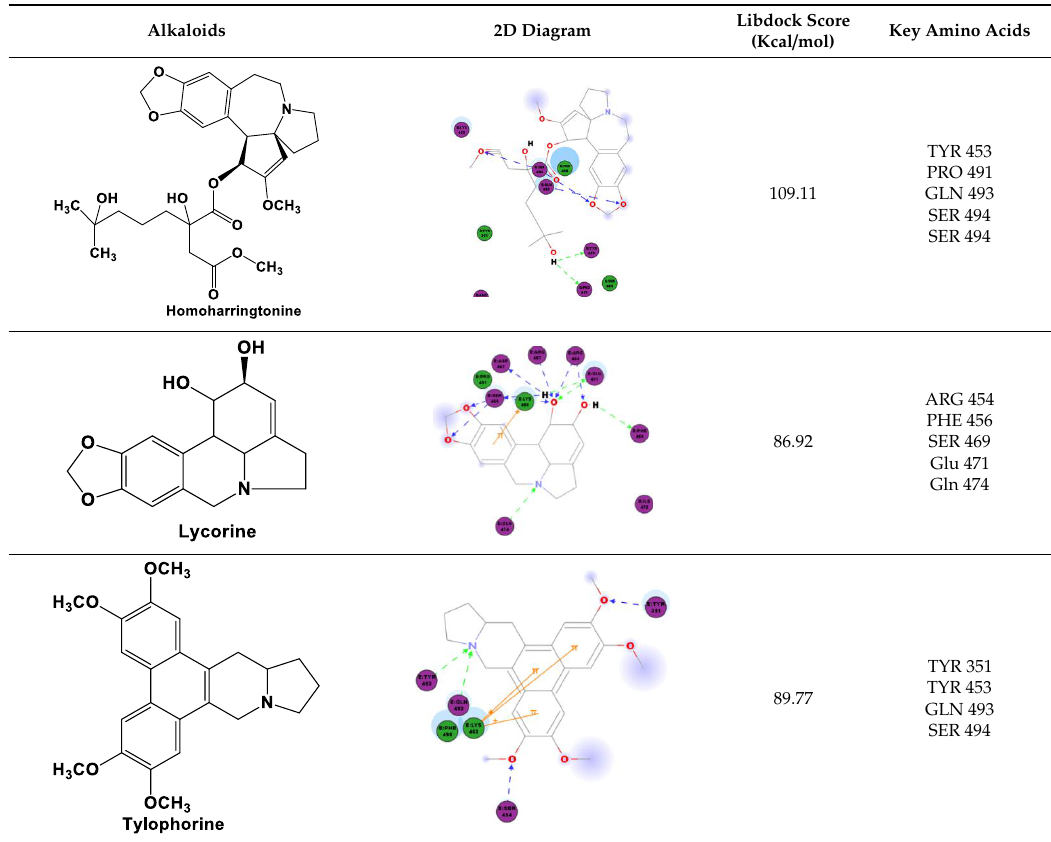
Table 3. Libdock score of the anti-coronavirus alkaloids and the key amino acids involved in the H-bond interaction with the compounds. Alkaloids